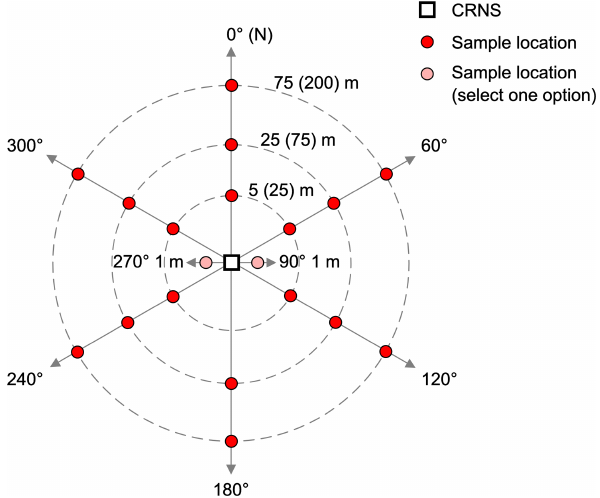
Figure 3. Plan view of soil sampling locations (not to scale). Dis- tances used prior to 14 September 2016 are shown in